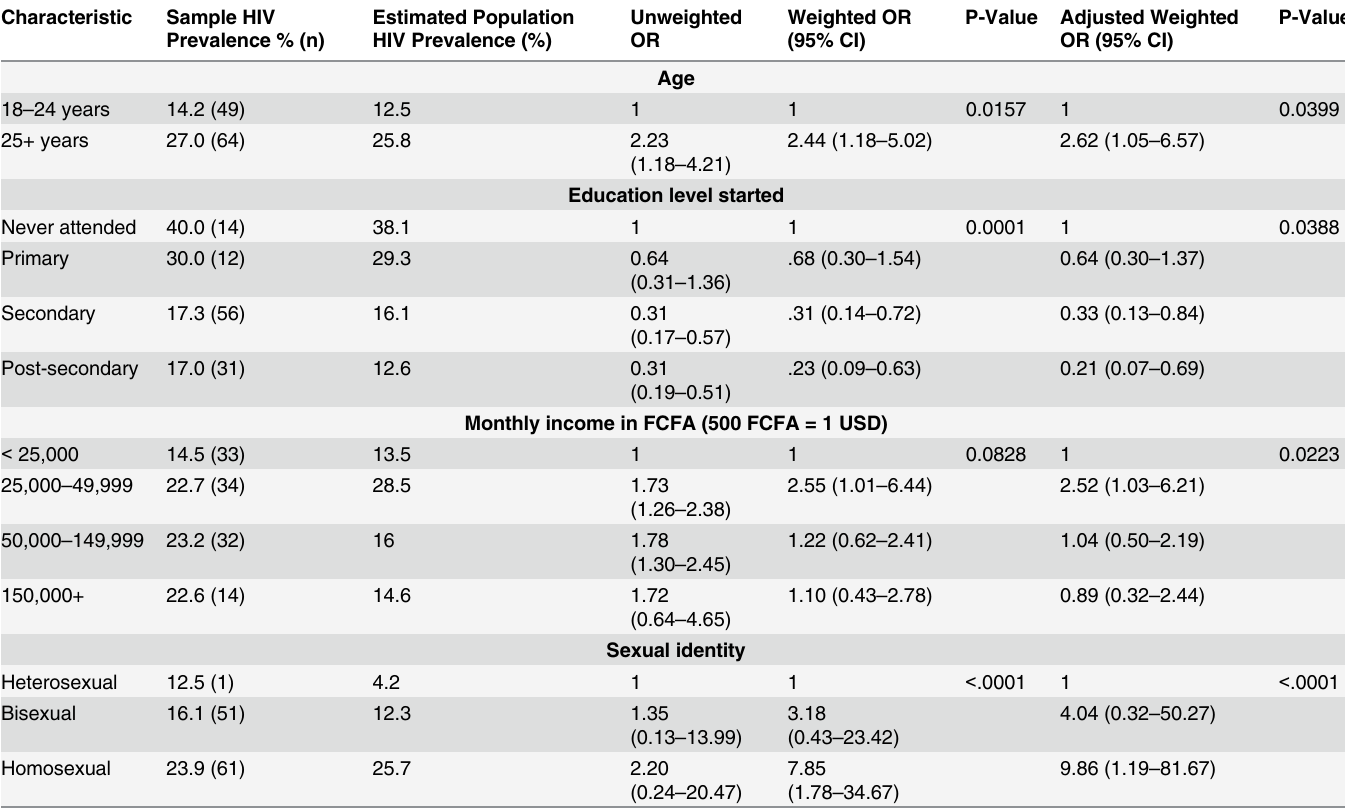
Table 3. Key Correlates of HIV Infection Among MSM in Abidjan, Côte d ’ Ivoire, 2011 – 2012 (n = 581).